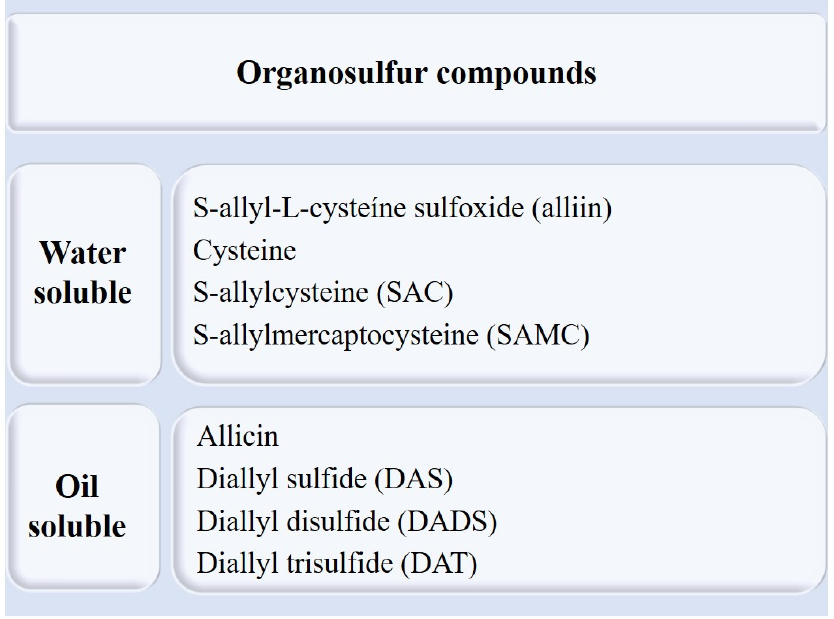
Figure 2. Organosulfur compounds of garlic.